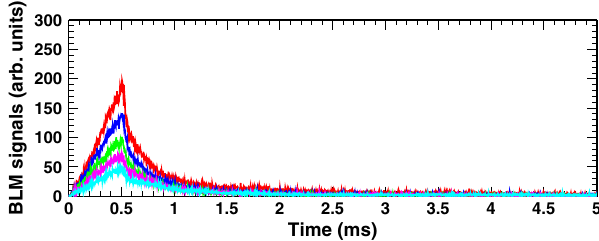
FIG. 27. Scintillation-type BLM signals over the first 5 ms measured at the collimator section with various beam intensities of 473 (light blue), 606 (pink), 731 (green), 870 (blue) kW and 1 MW (red) after the rf power supply